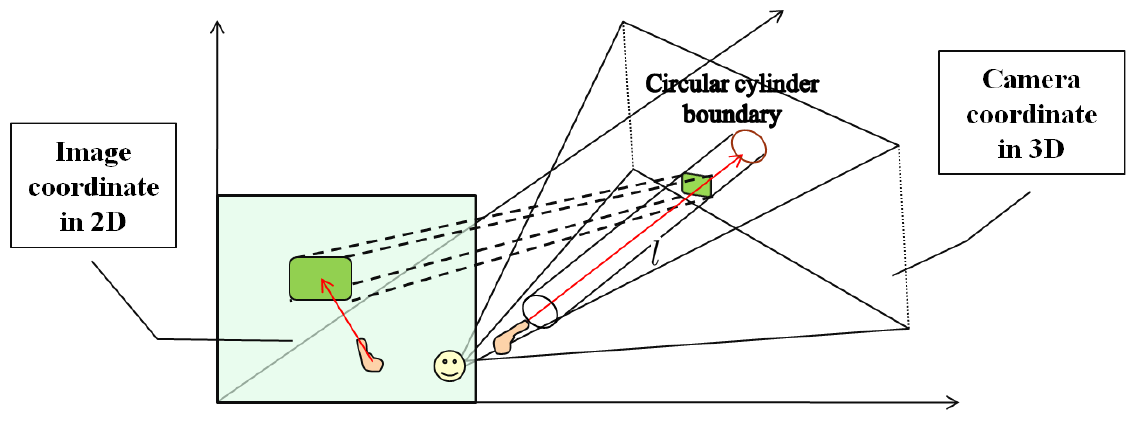
Figure 5. Relationship between the image coordinates and the camera